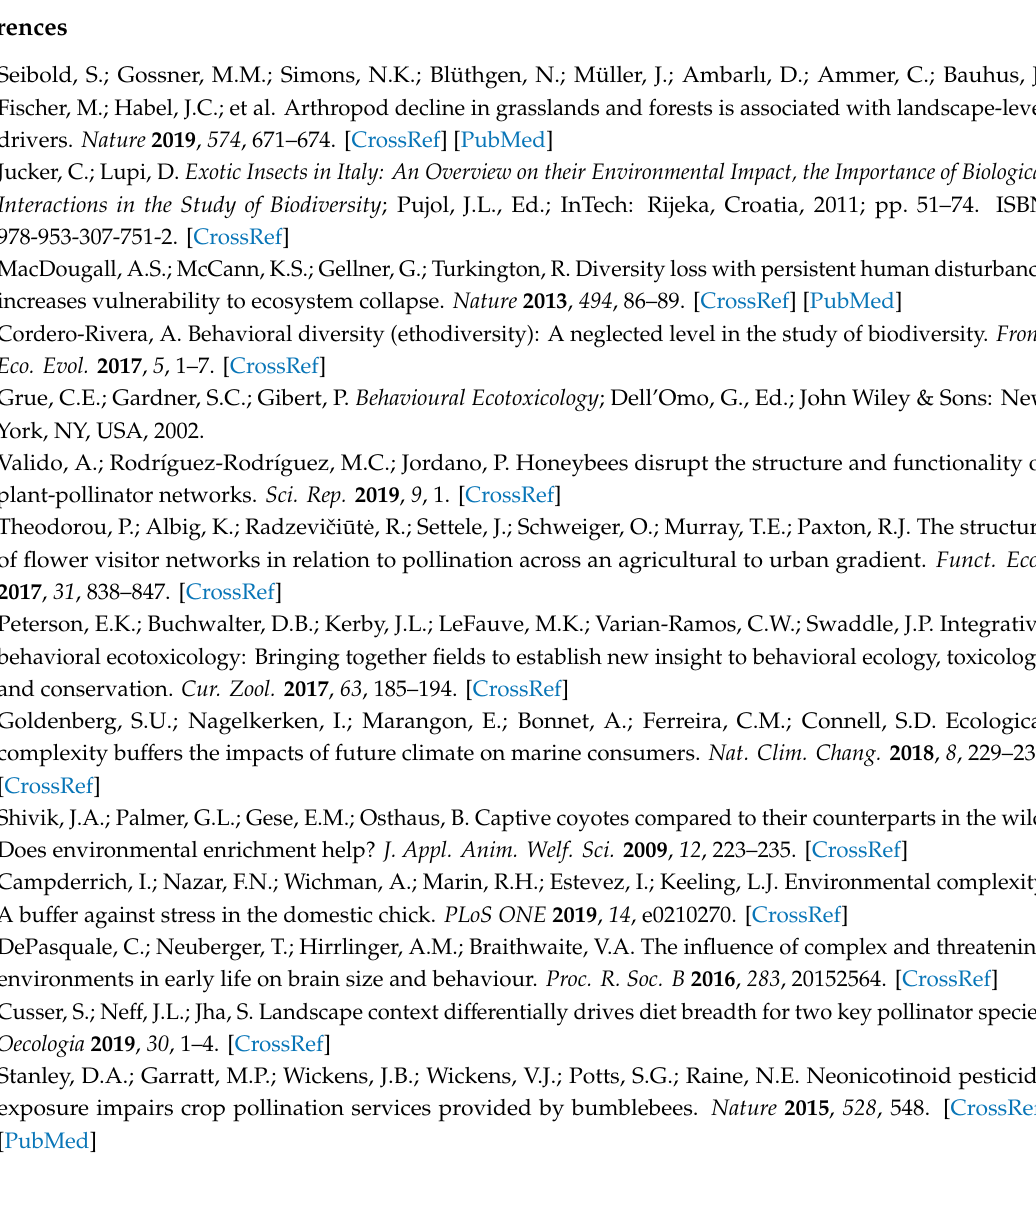
Figure S1: Experimental flight cages, Figure S2: Visualization of visitation rate and exploitation per individuals, Figure S3: Complete panel with results of all models, Table S1: Experimental